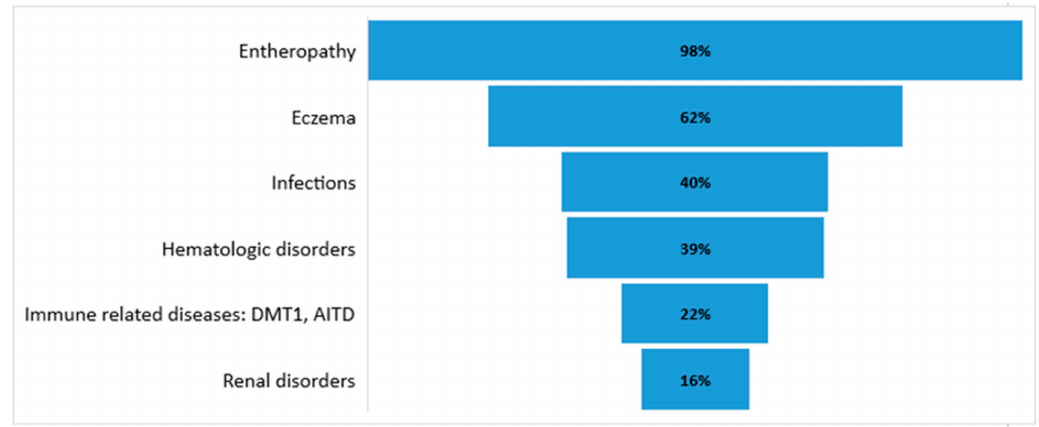
Figure 2. The occurrence of clinical symptoms of IPEX syndrome